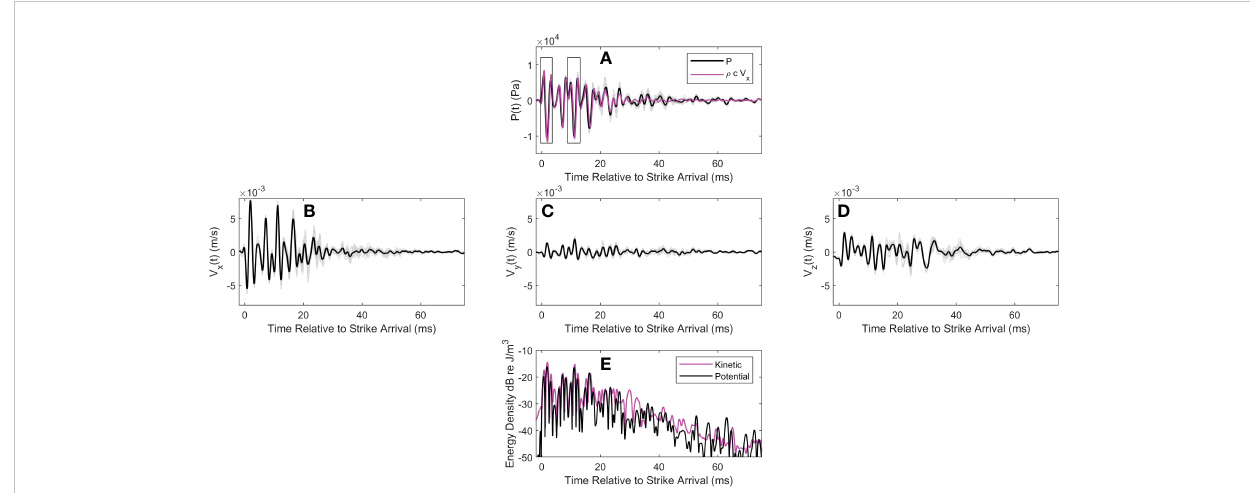
FIGURE 4 (A) coherent average of pressure over N strikes (cid:1) p ( t ) (black line) and individual strike time series p n ( t ) (gray lines). Measurements are from pile T8 at range 10 m. Magenta line shows coherent average of the x -component of acoustic velocity (cid:1) v x ( t ) scaled by r w c w . For this display the sign of (cid:1) v x ( t ) is fl ipped. Data shown within the two boxes (duration 4-ms) are used in subsequent analysis. Time is relative to the pile strike arrival. (B) Coherent ( t ) (gray lines); (C, D) provide similar display of (cid:1) v y ( t ) and (cid:1) v z ( t ), respectively, together with the average of (cid:1) v x ( t ) along with individual strike time series v x n individual strike time series (gray lines). (E) Time varying potential (black line) and kinetic (magenta line) energy density averaged over N strikes.